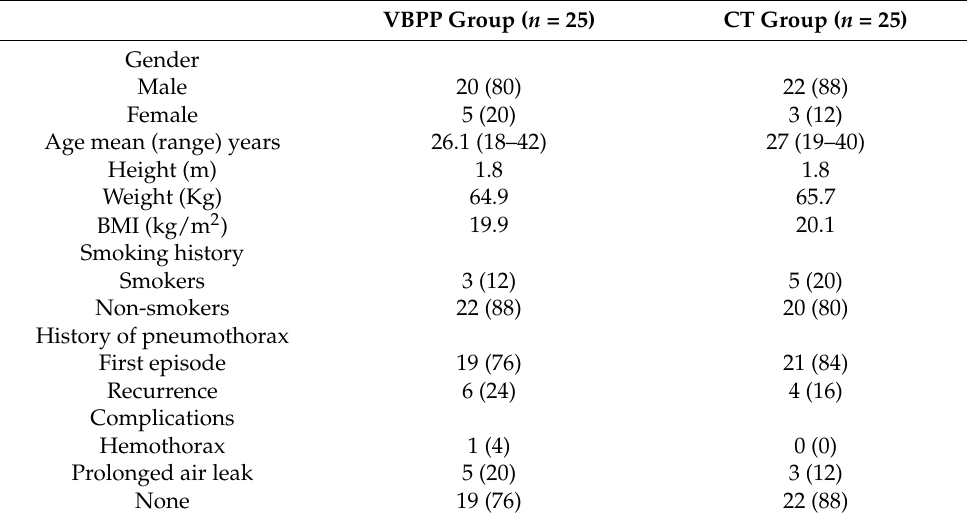
Table 1. Clinical characteristics of the VBPP and CT groups.